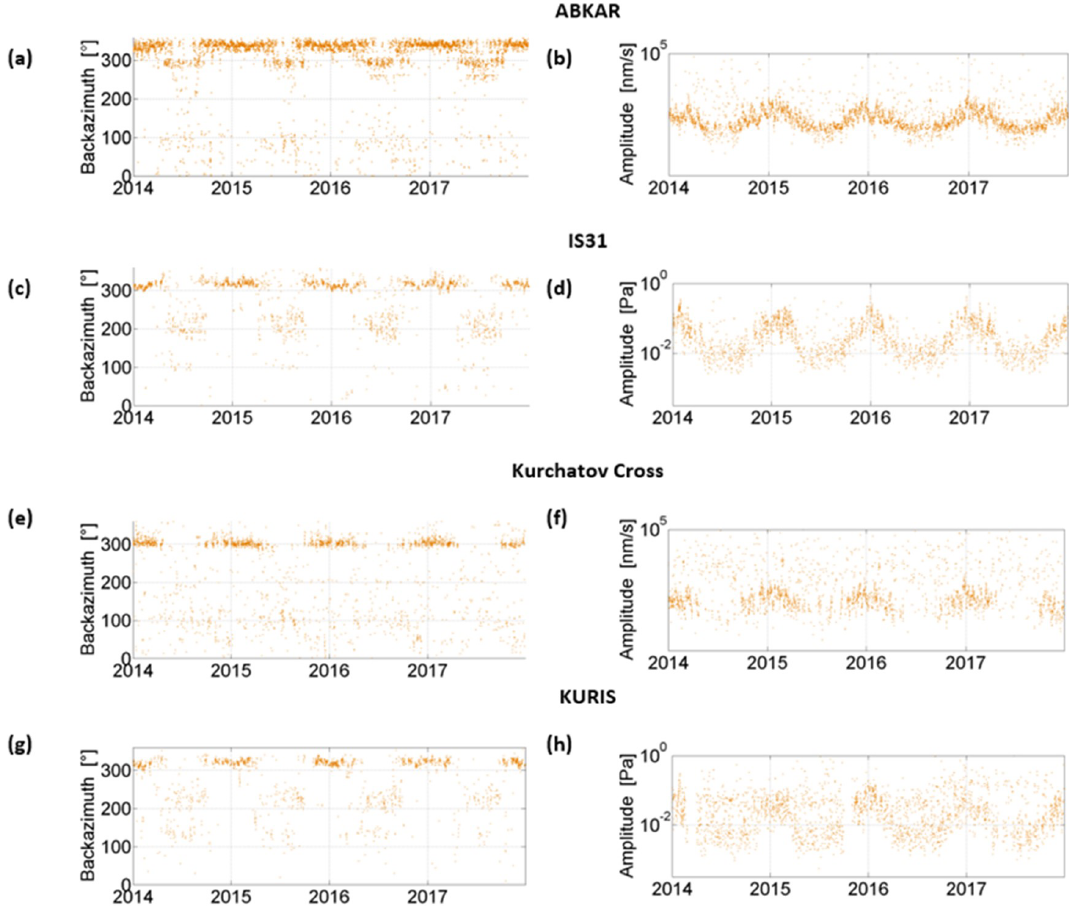
Figure 5. Comparison of the observed back-azimuths and amplitudes at ABKAR (a, b) and IS31 (c, d) , 230km apart, and collocated Kurchatov Cross (e, f) and KURIS (g, h)